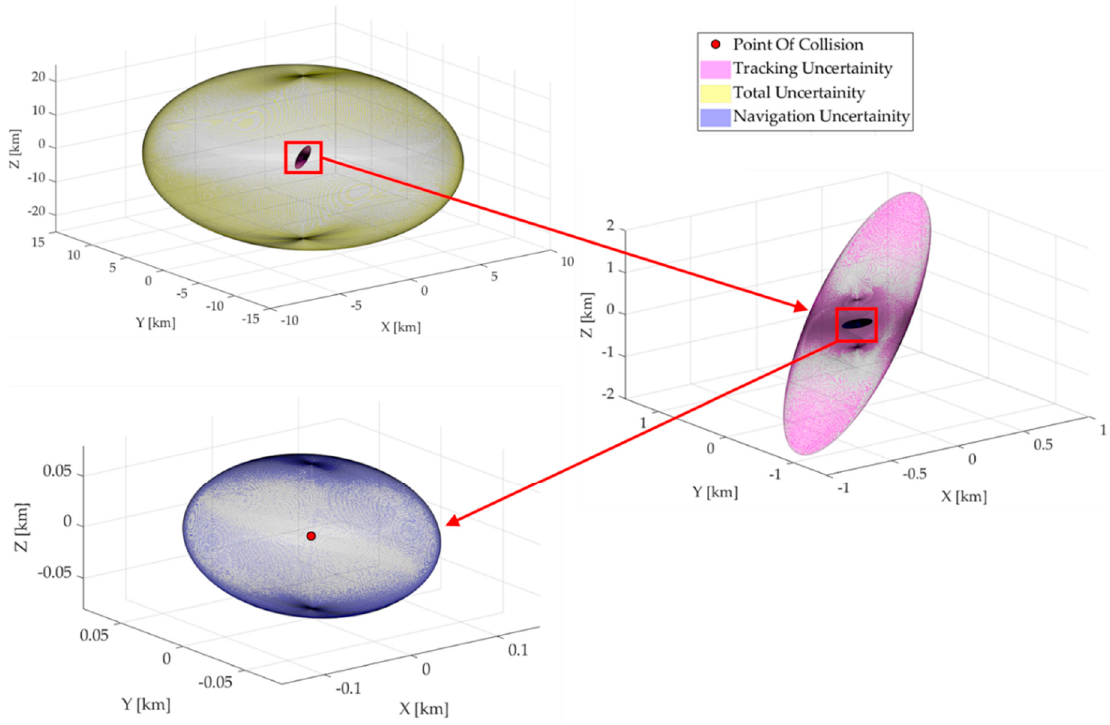
Figure 12. Uncertainty volumes around the tracked RSO in ground-based scenario.